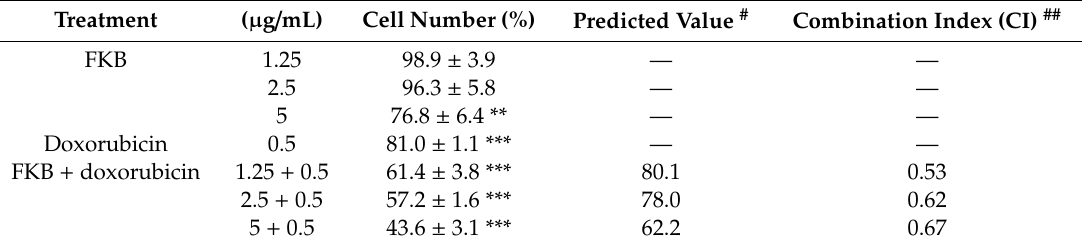
Table 2. The synergism e ff ects of FKB and doxorubicin on SCM-1 cells. Treatment